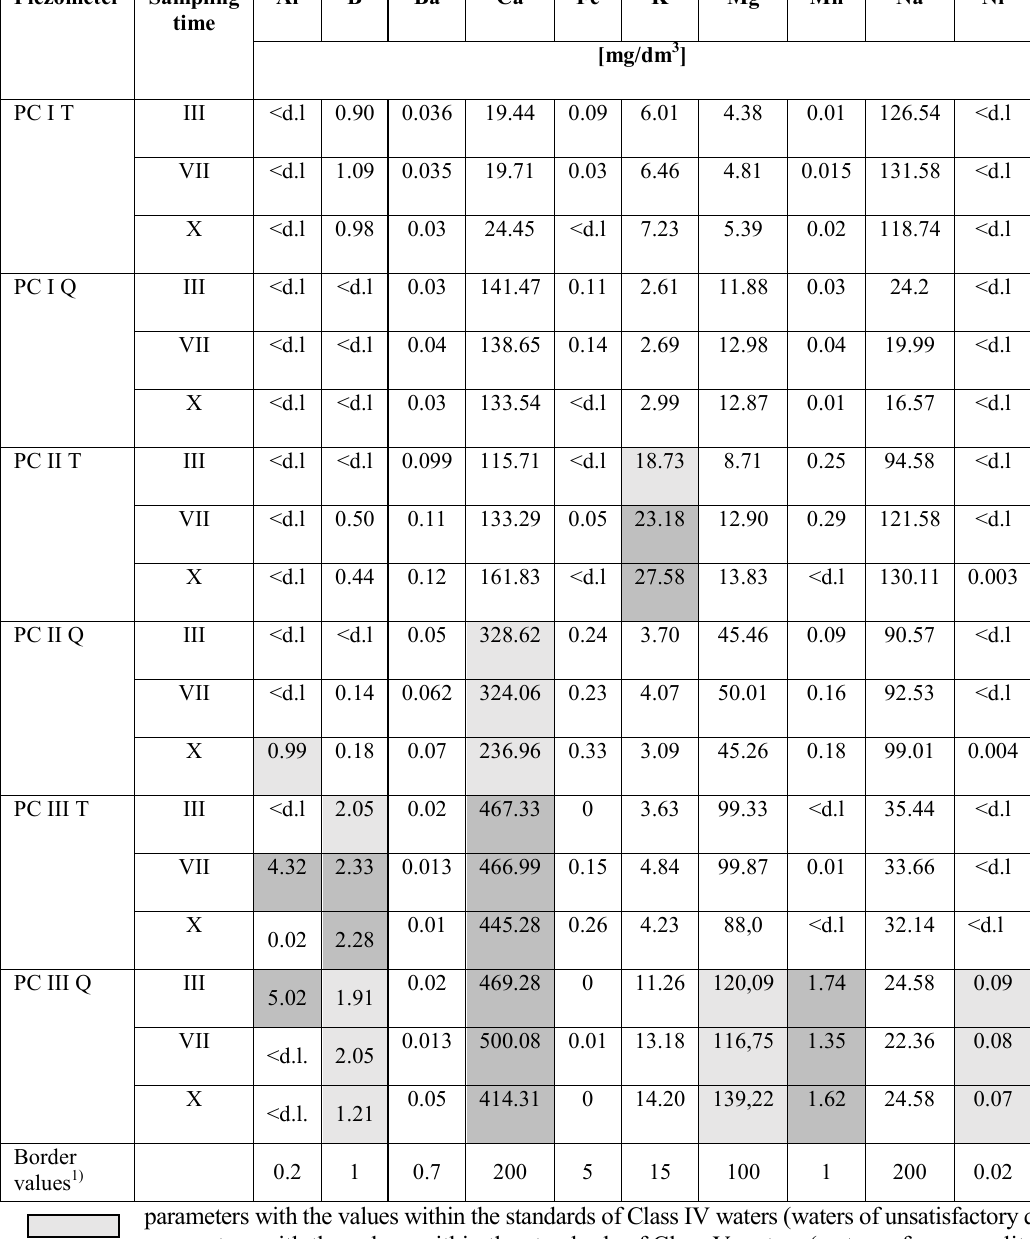
parameters with the values within the standards of Class IV waters (waters of unsatisfactory quality) parameters with the values within the standards of Class V waters (waters of poor